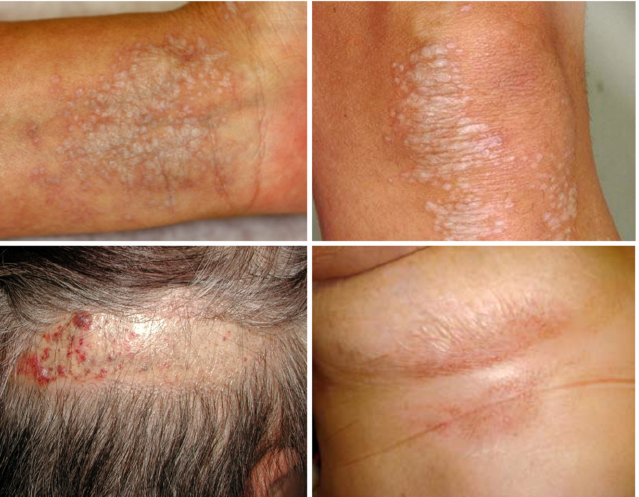
Figure 2. Clinical features of LS developed on the extragenital skin. The extragenital LS occurs at any skin sites, including extremities ( upper left and right ), scalp ( lower left ), and trunk ( lower right